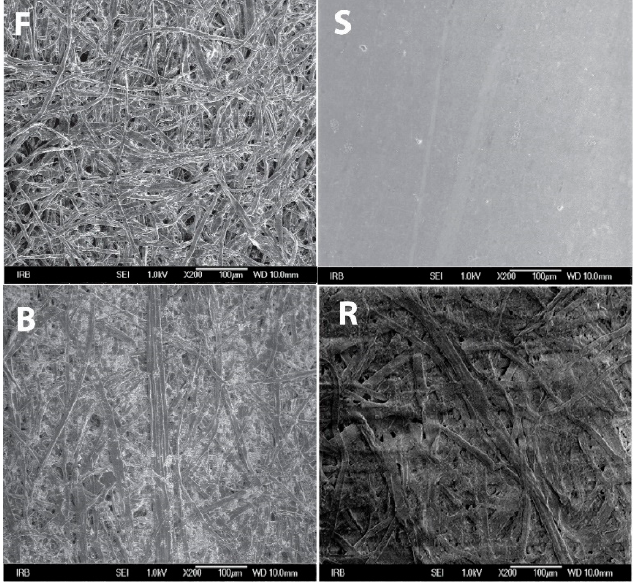
Figure 2. SEM micrograph of paper samples (magnification of 200 × ); F-filter paper, S-synthetic paper, B-bulky paper, R-recycled paper.